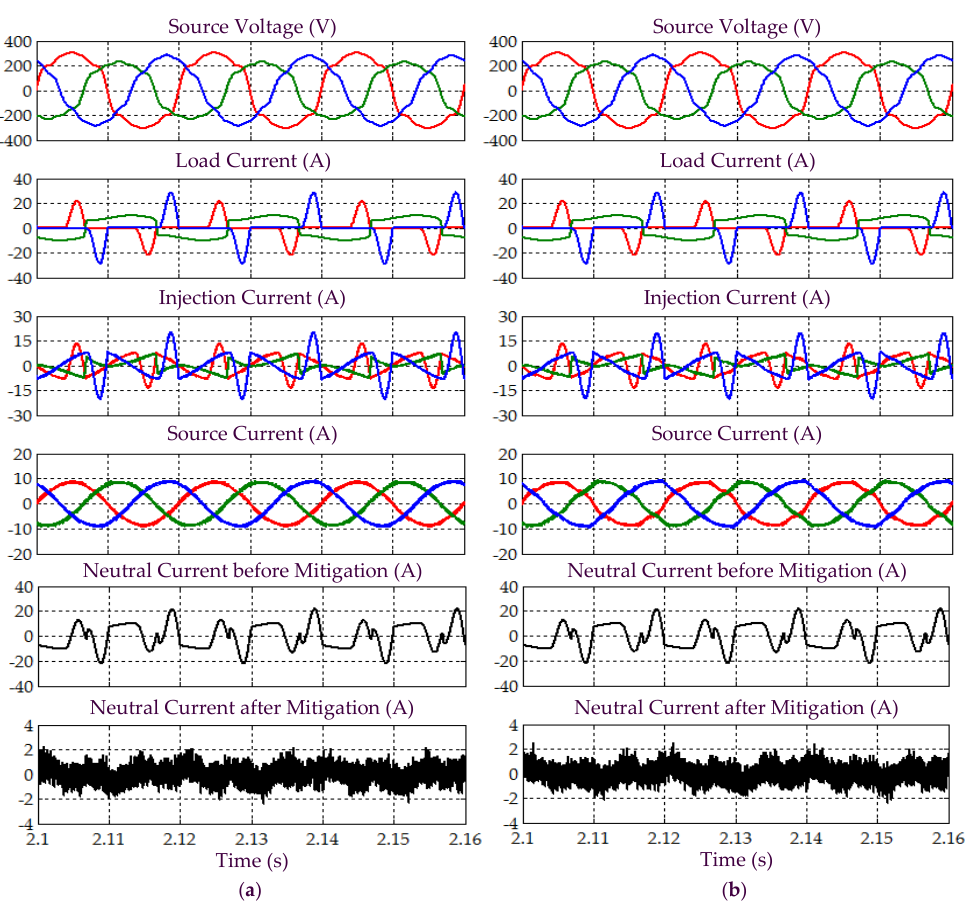
Figure 21. Simulation results obtained under Scenario D for Load 1, which include three-phase source voltage v Sabc , load current i Labc , injection current i injabc , source current i Sabc , and neutral current before and after mitigation, demonstrated by SAPF while applying the ( a ) proposed STF- dq 0 and ( b ) standard dq 0